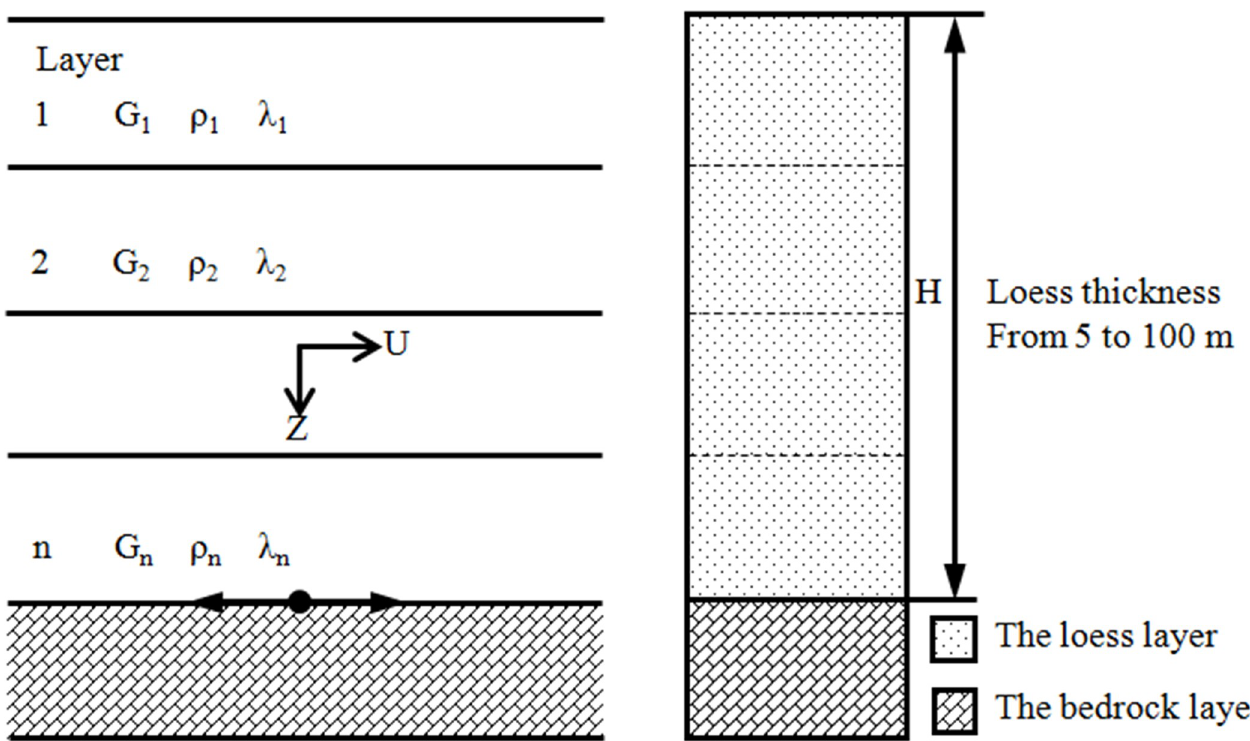
Fig 3. One-dimensional idealization calculation